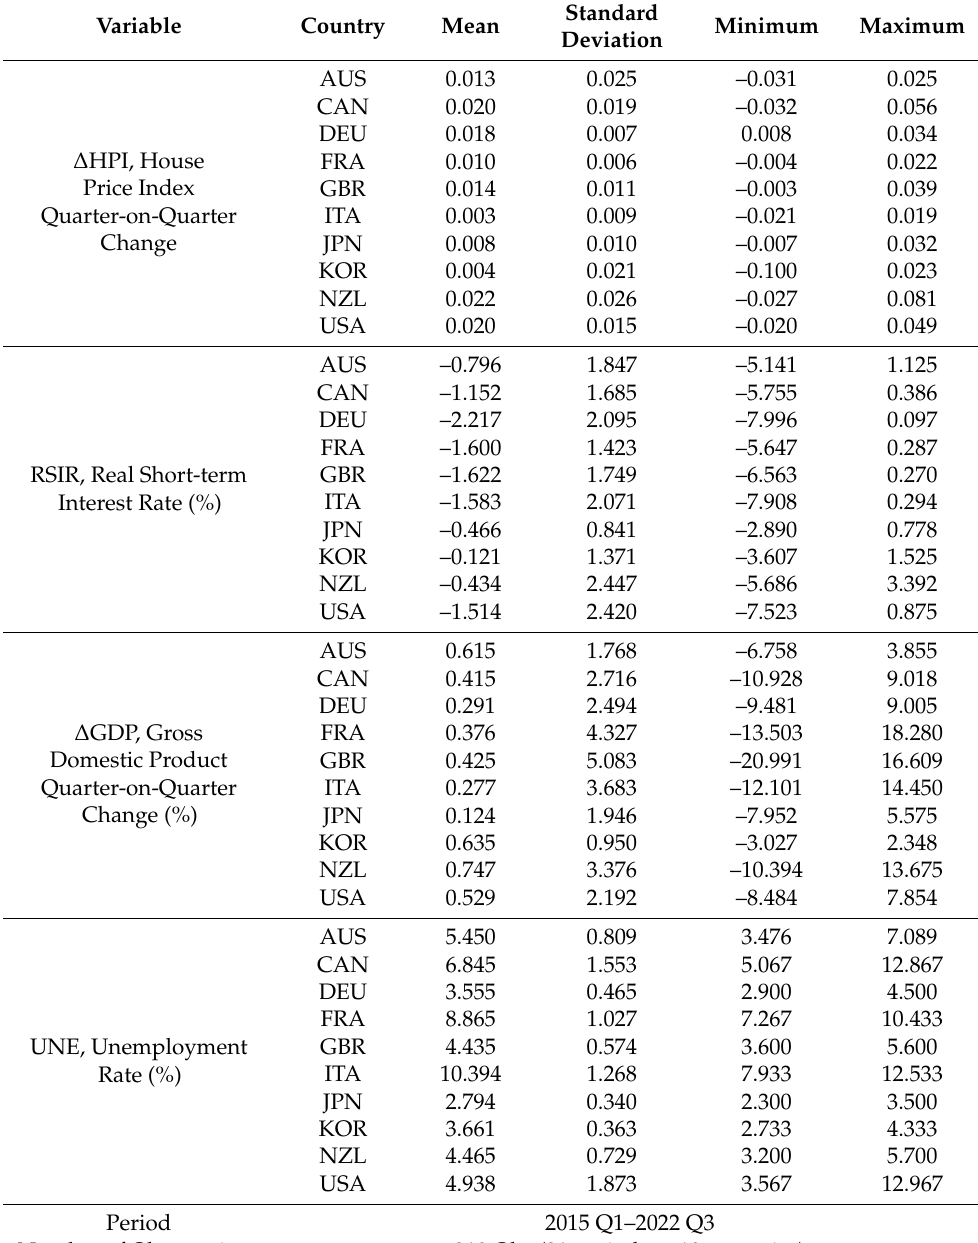
Table 1. Descriptive Statistics of Variables for 2015 Q1–2022 Q3. Sources: OECD (2022a)